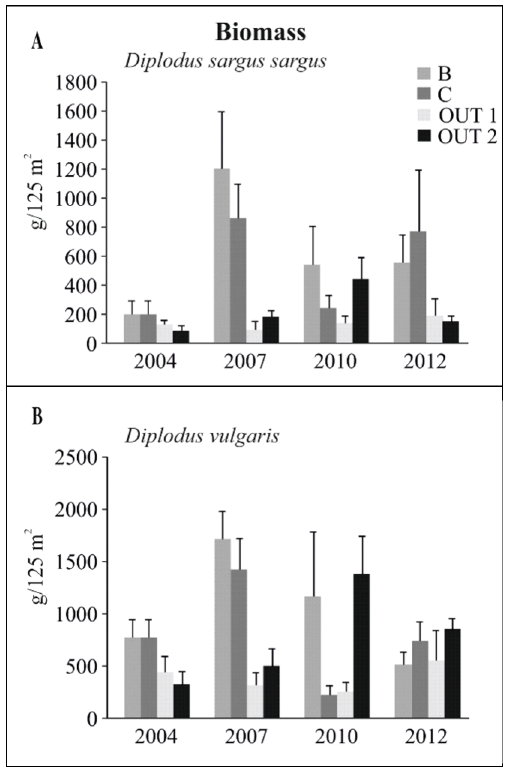
Fig 6. Reserve effect on the two main commercial species in the area. (A) Diplodus sargus sargus .(B) Diplodus vulgaris . Mean values ( ± SE) of biomass.